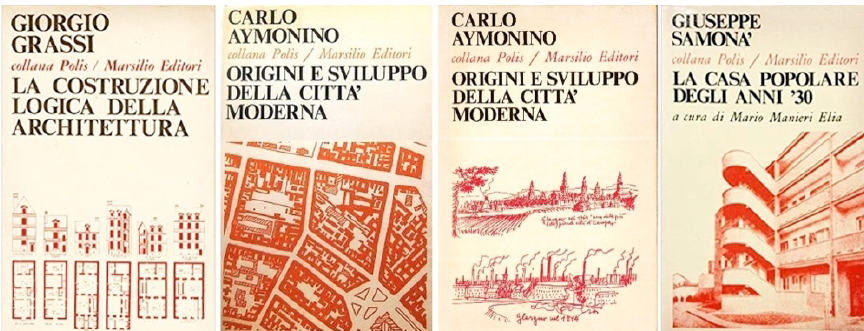
Figure 7. Publications dedicated to the theme of the city and urban architecture. From left to right: Giorgio Grassi, La Costruzione Logica dell’Architettura ( The Logical Construction of Architecture ), 1966; Carlo Aymonino, Origini e Sviluppo della Città Moderna ( Origins and Development of the Modern City ), 1971 and 1975 (2nd edition); Giuseppe Samonà, La Casa Popolare degli Anni 30 ( Social Housing in the 1930s ), 1972.